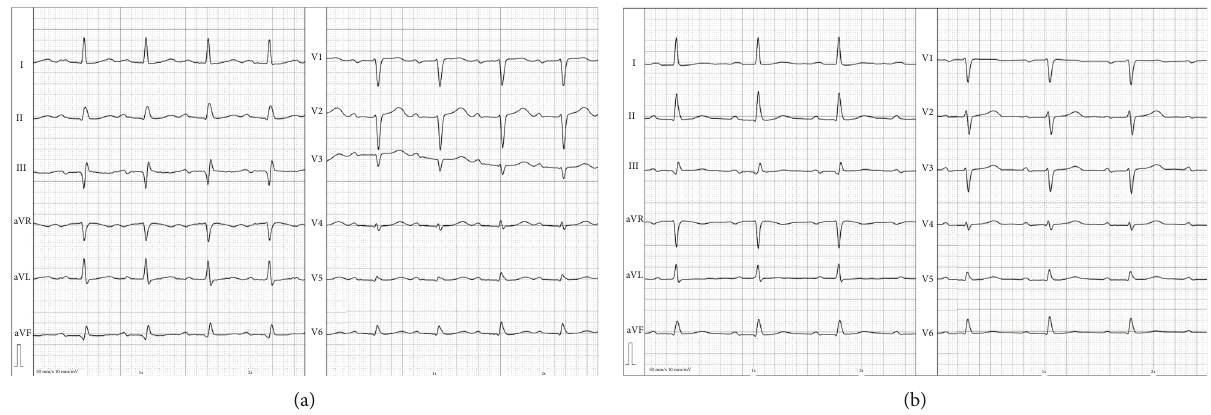
Figure 1: (a) 12-lead surface ECG before the intervention.(b) 12-lead surface ECG after the intervention with no change in the PQ interval.